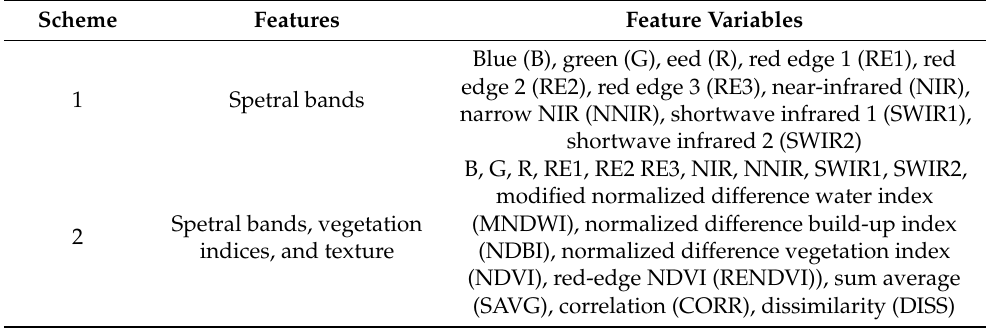
Table 1. S-2A schemes with different